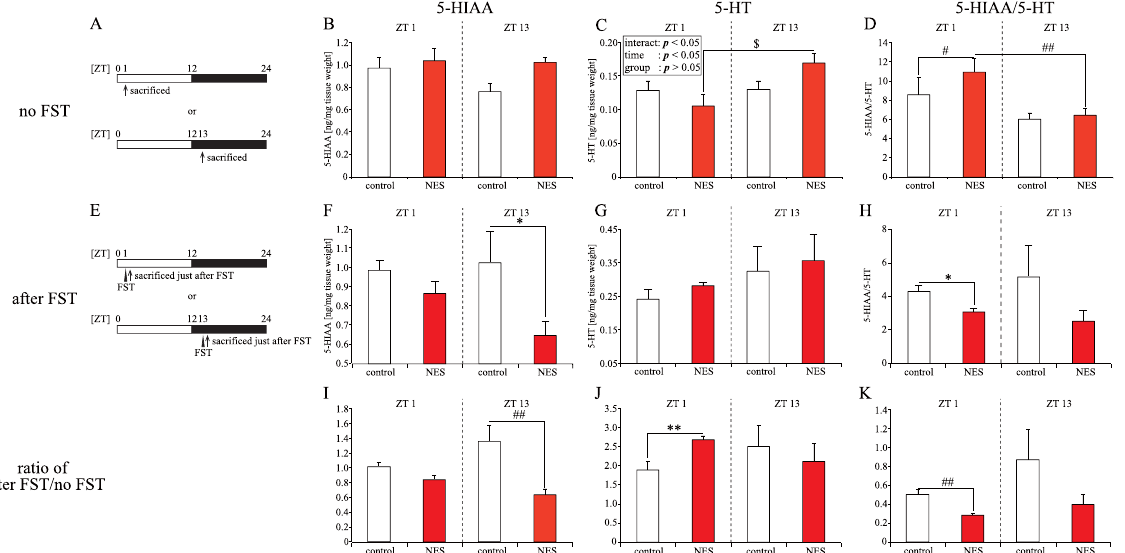
Figure 6. Effect of RF duration of 5-min with HFD at ZT 5 on 5-HT secretion and metabolism in the hippocampus at ZT 1 and 13 with and without FST (Experiment 6). ( A ) Sampling schedules. Mice were sacrificed at ZT 1 or 13 without FST, after mice were kept on each feeding condition for 4 weeks (no FST). ( B – D ) The 5-HIAA ( B ), 5-HT ( C ), and the metabolic rate (5-HIAA/5-HT; D) levels in the hippocampus at ZT 1 and 13. ( E ) Sampling schedules. Mice were sacrificed at ZT 1 or 13 just after the FST, after mice were kept on each feeding condition for 4 weeks (after FST). ( F – H ) The 5-HIAA ( F ), 5-HT ( G ), and the metabolic rate (H) levels in the hippocampus at ZT 1 and 13 just after the FST. ( I – K ) Stress reactivity of 5-HIAA ( I ), 5-HT ( J ), and metabolic rate ( K ) in the hippocampus. We calculated these levels by dividing each level after FST by the average with no FST. We show the results of two-way ANOVA in C. Data are presented as the mean ± SEM ( n = 6–8). * p < 0.05, ** p < 0.01 (Student’s t -test); # p < 0.05, ## p < 0.01 (Mann-Whitney test); $ p < 0.05 (two-way ANOVA with Tukey’s multiple comparison test).